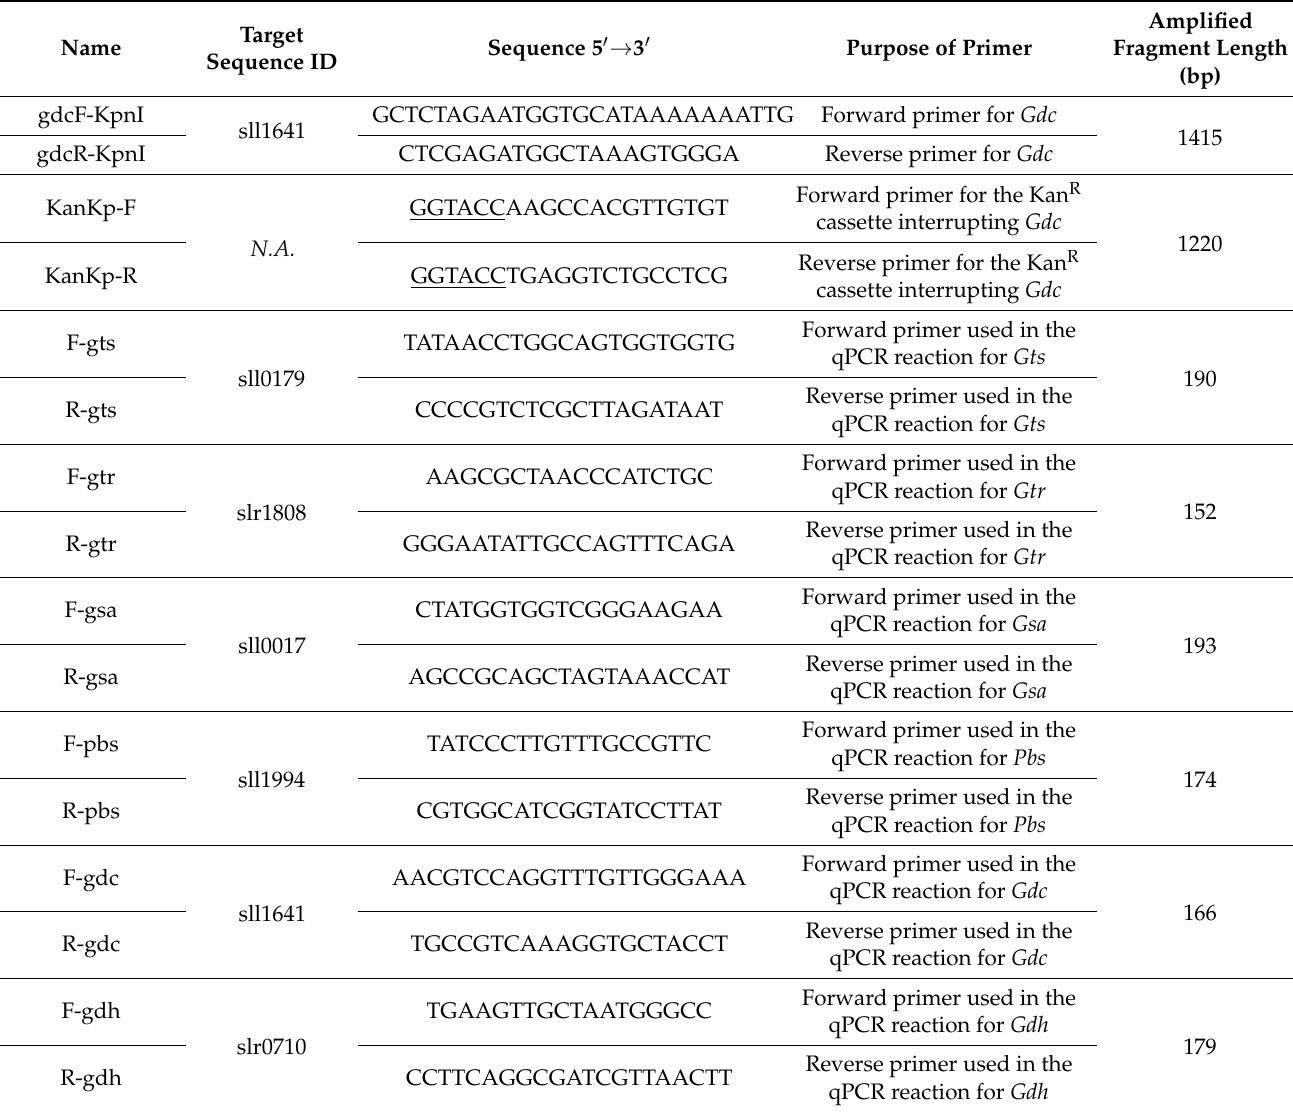
Table 1. Oligonucleotides used in this study and their relative IDs as registered in the Cyanobase (http://genome.microbedb.jp/cyanobase/GCA_000009725.1, accessed on 7 April 2022); restriction sites are